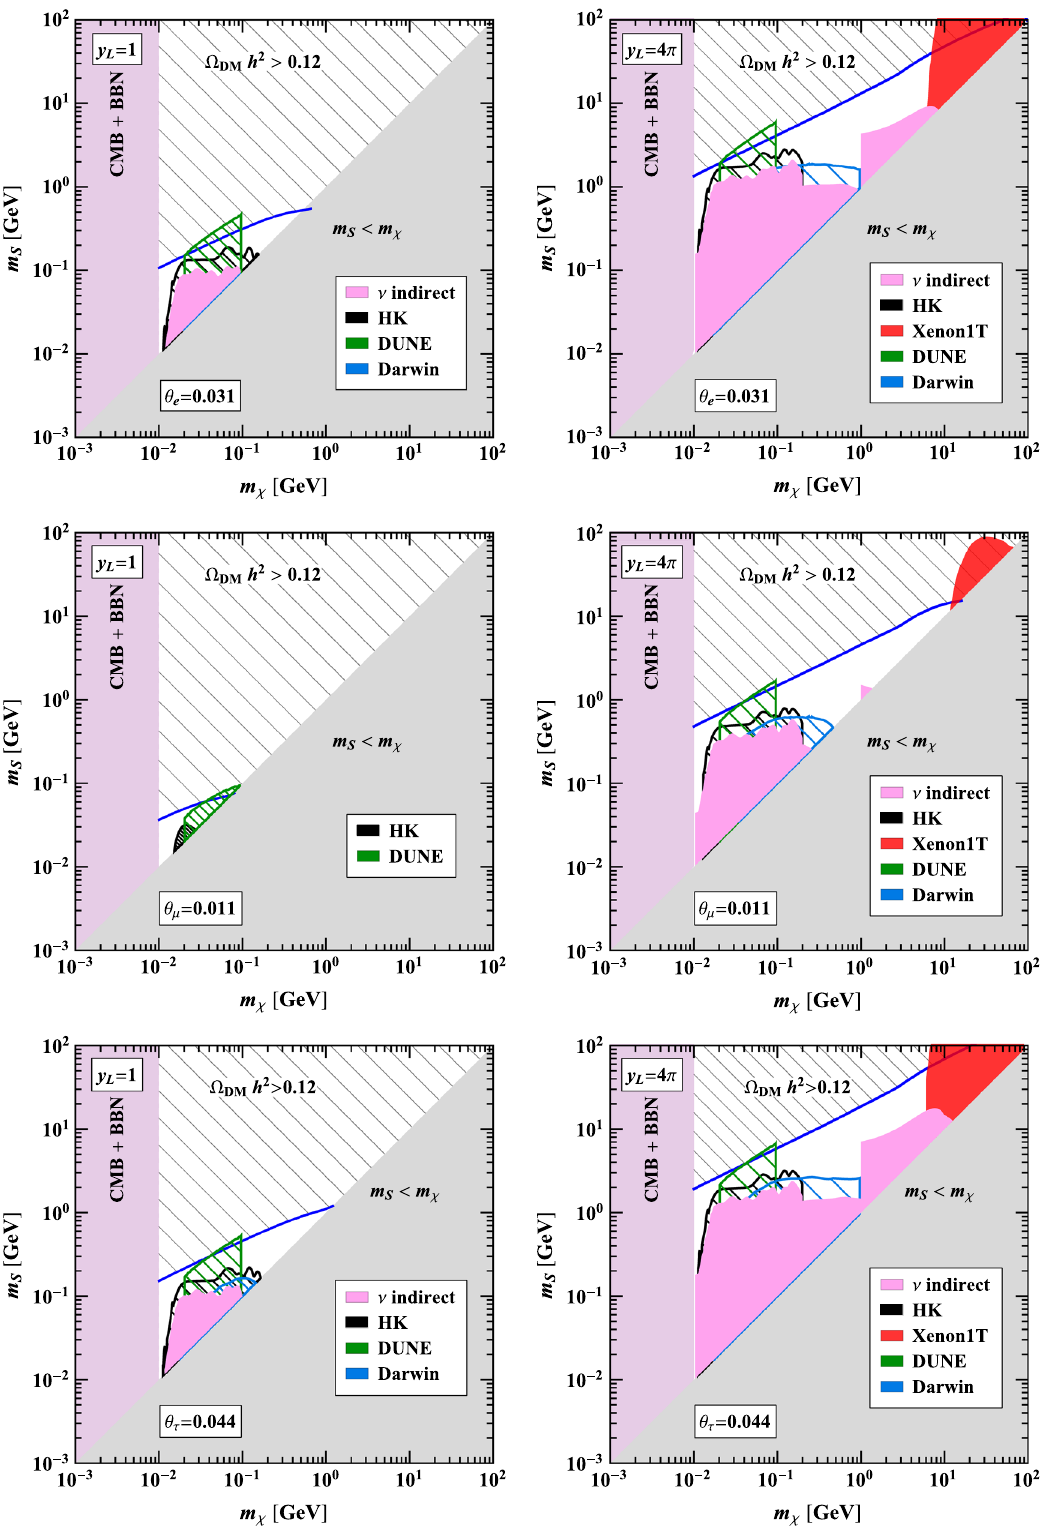
Fig. 5 Constraints on the DM mass m χ and the dark scalar mass m S . value. The coloured shaded regions are excluded by different experi- We have fixed θ e = 0 . 031, θ μ,τ = 0; θ μ = 0 . 011, θ e ,τ = 0; and ments, while the hatched areas correspond to prospective sensitivities θ τ = 0 . 044, θ = 0 (from top to bottom), considering y = 1 and of future experiments. The lower bound m χ (cid:3) 10 MeV is set by obser- e ,μ L 4 π . Along the blue line the DM relic density matches the observed vations of the CMB and BBN. See text for further